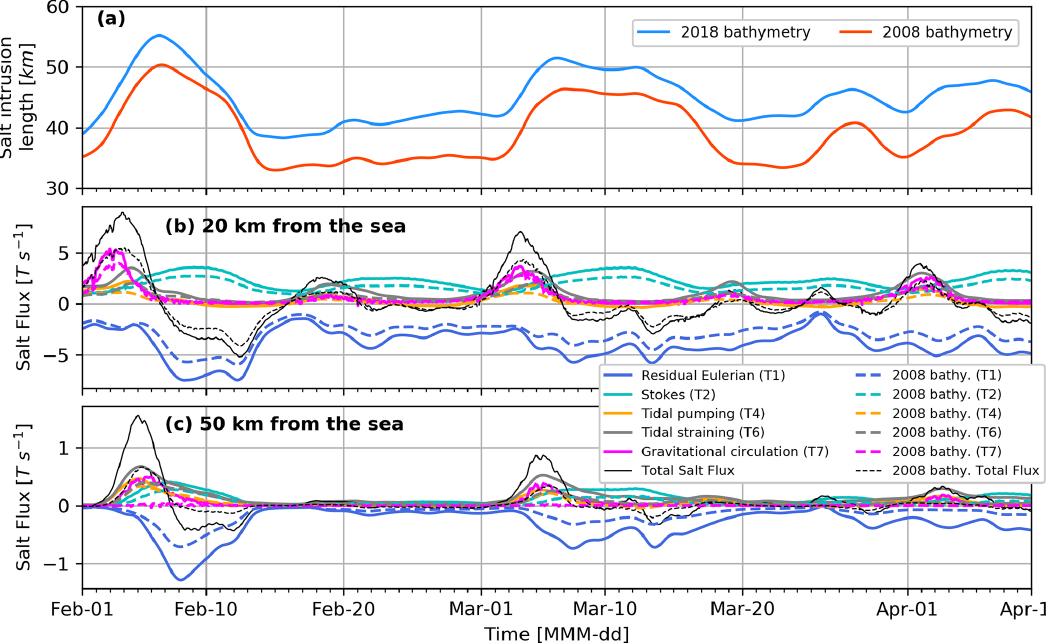
Figure 13. Variation in tidally averaged salt intrusion length in the Ham Luong channel under existing (2018) and the older (2008) bathyme- tries (a) . Major salt flux mechanisms under two bathymetries at 20km (b) and 50km (c) from the